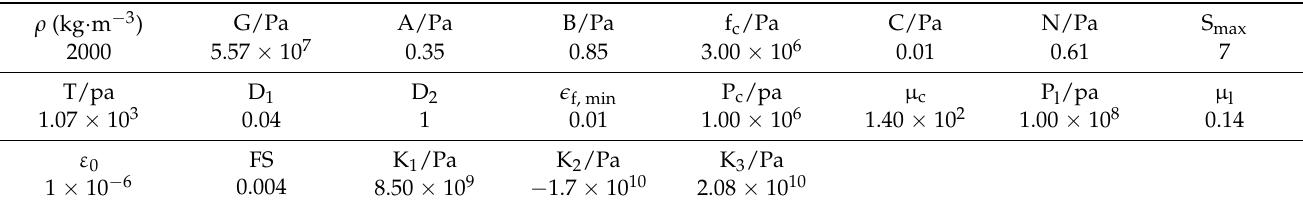
Table 3. HJC model parameters.